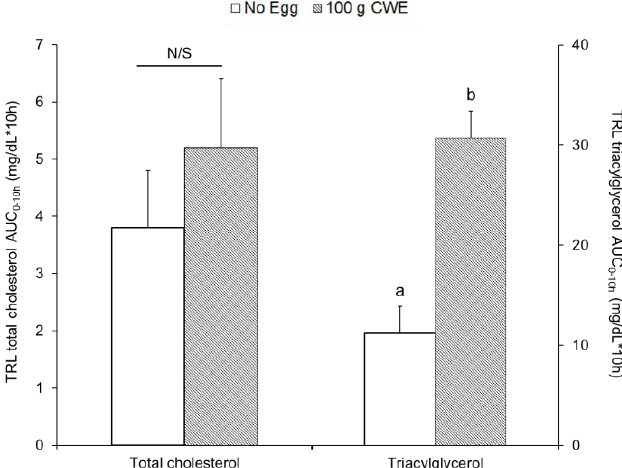
Figure 3. Total cholesterol and triacylglycerol AUC 0 – 10h within TRL fractions in study 2. Values are lsmean ± SE and different superscript letters (a, b) indicate statistical differences between no egg and 100 g CWE ( p < 0.0001). AUC, areas under the curve; CWE, cooked whole egg; N/S, not significant; TRL, triacylglycerol-rich lipoprotein.